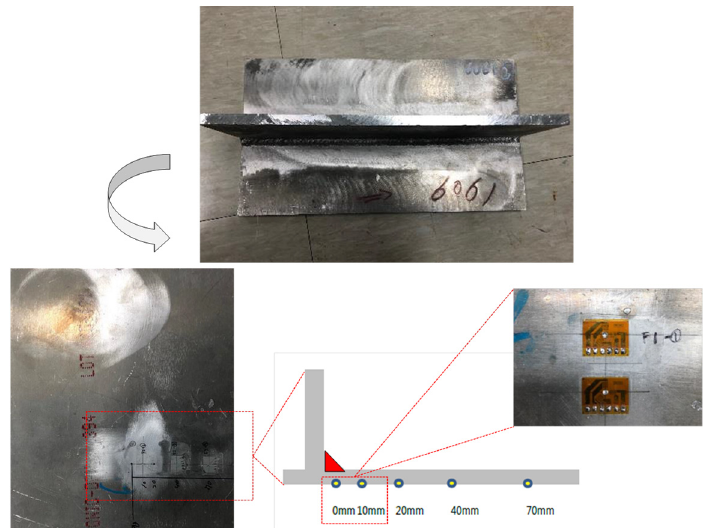
Figure 18. Location of attached stain gauge.